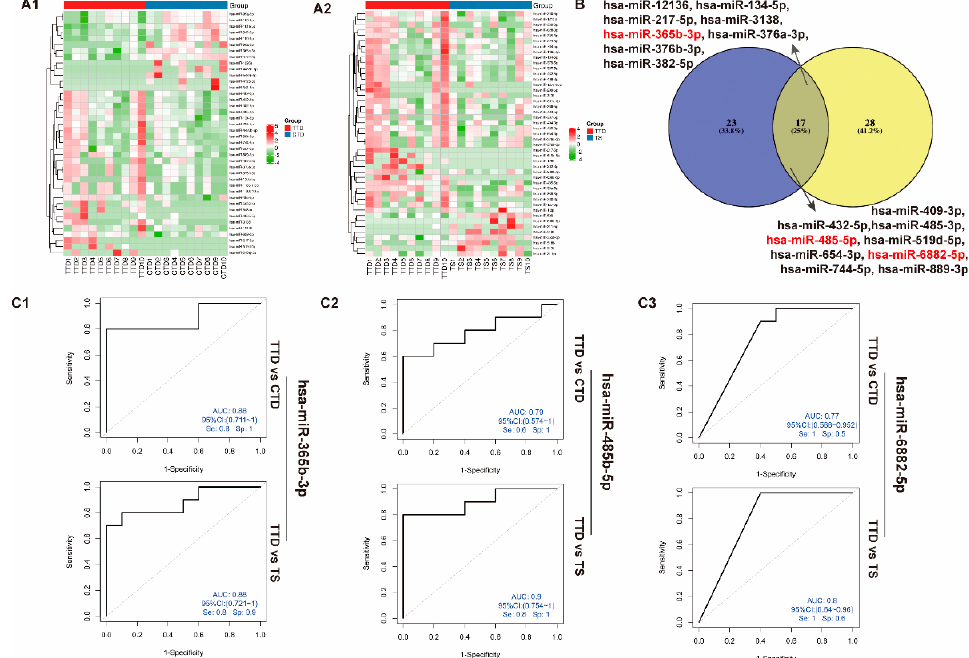
Figure 5. Identification and characterization of differentially expressed miRNAs in TTD and matched CTD or TS. ( A ) The heat map analysis identifies the significant differentially expressed miRNAs (DEMs). The two heat maps, ( A1 ) and ( A2 ), represent transient tic disorder patients (TTD) versus chronic motor or vocal tic disorder patients (CTD) and TTD versus Tourette syndrome patients (TS), respectively. The color bar on the right side represents the scale for the Z-score. The red color indicates high expression, and the green color indicates low expression. Representative micro-RNAs are shown on the right side of the heat map. ( B ) The Venn-diagram for the two comparisons TTD versus CTD and TTD versus TS. The coincident part indicates 17 DEMs shared between the two comparisons. ( C ). Receiver operating characteristic (ROC) analyses of differentially expressed miRNAs in TTD, CTD, and TS. Three miRNAs, including hsa-miR-365b-3p ( C1 ), hsa-miR-485b-5p ( C2 ), and hsa-miR-6882-5p, were selected from the coincident part DEMs between the two comparisons ( C3 ).